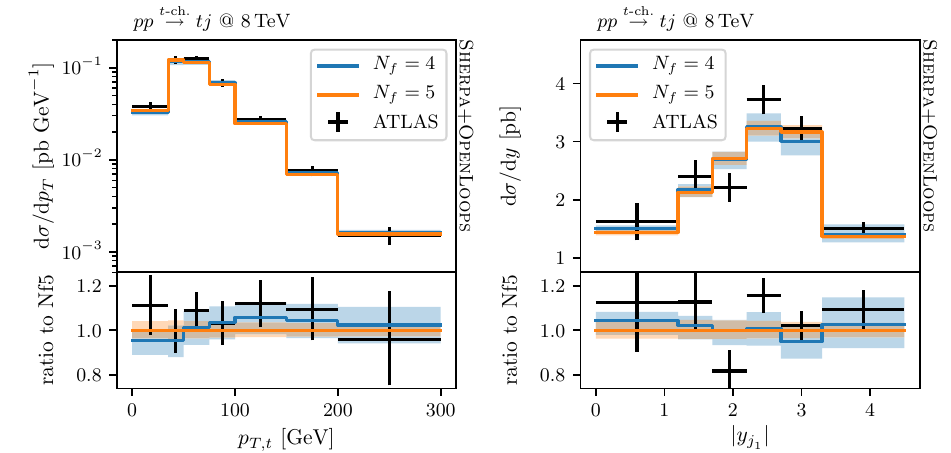
Fig. 2 Comparison of S HERPA M C @N LO predictions with ATLAS data [10] for the top-quark transverse momentum p T , t and the light-jet rapidity y j in t -channel single-top production. The S HERPA uncertainty 1